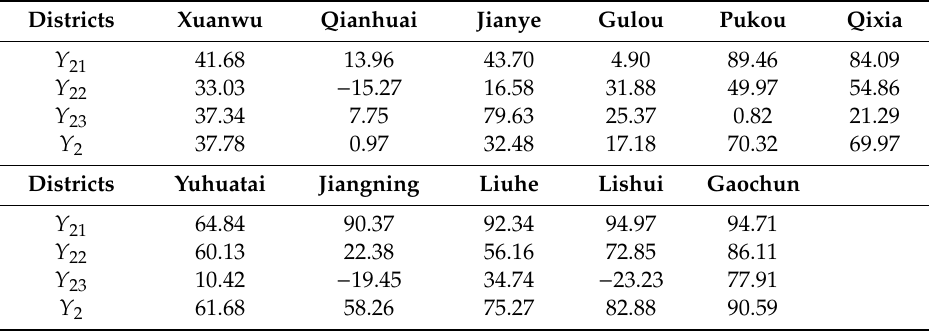
Table 11. Coe ffi cient of indictors in Nanjing